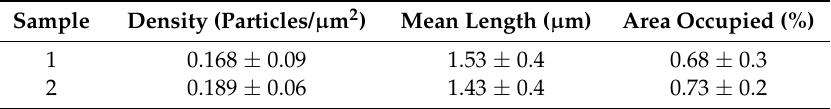
Figure 9. Carbide distribution for Samples 1 and 2.